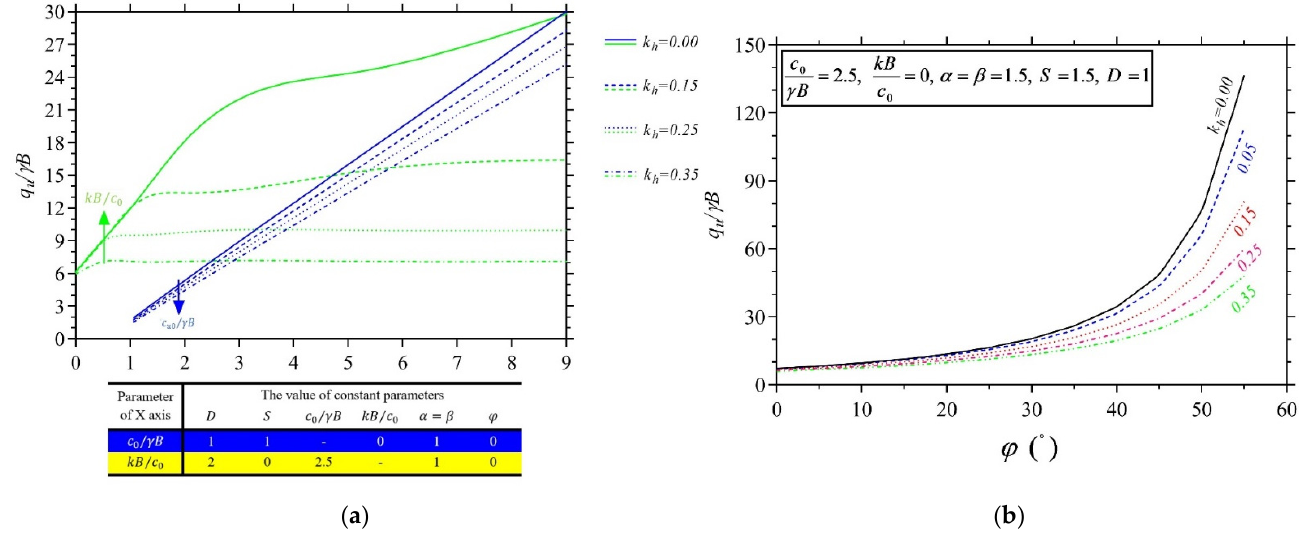
Figure 4. Parametric analysis: effects on the bearing capacity Q = q u / γ B under different values of the seismic acceleration coefficient k h , of: ( a ) the dimensionless soil parameters c 0 / γ B (blue plots) and kB / c 0 (yellow plots); ( b ) internal friction angle ϕ .